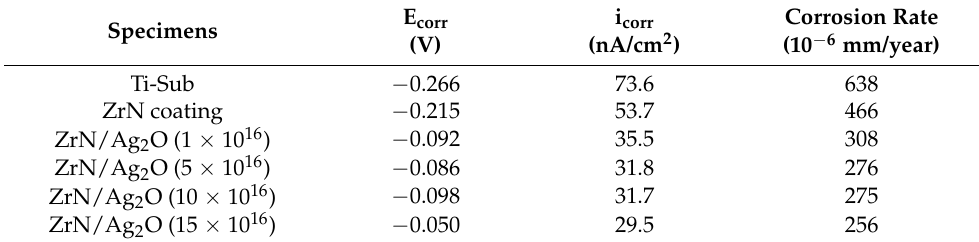
Figure 9. Potentiodynamic polarization and EIS measurements of different specimens in Ringer’s solution: ( a ) the typical potentiodynamic polarization curves recorded on the substrate, separate ZrN coating and ZrN/Ag 2 O micro–nano gradient composite coatings with different doses of silver ions; ( b , c ) the representative Nyquist and Bode plots for the tested samples, respectively; and ( d ) the equivalent circuit (EC) model used to simulate the EIS data of the composite coating and substrate in Ringer’s solution. Table 1. The acquired values of E corr , i corr and the corrosion rate of all